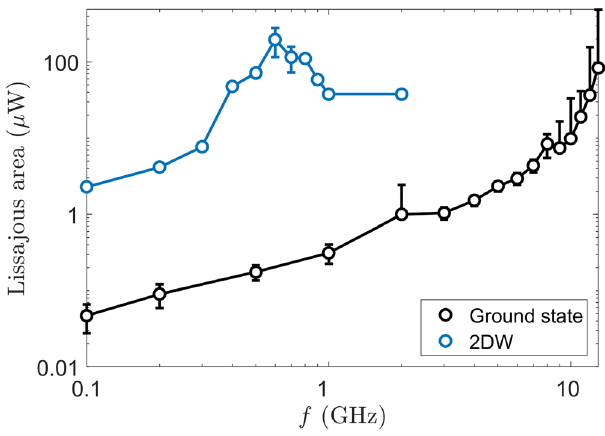
Fig. 6 Size of the memristive effects for domain walls (DW). Area spanned by the curves of the ground state and the 2DW state in Figs. 3 and 5. The area provide an estimate of how large is the change of the resistivity as a function of the frequency of the voltage input per unit of ampere, as in Eq. (5b). The peak in Lissajous area for the 2DW state is at f = 600 MHz. The error bars denote standard deviation of the area based on numerical fl uctuations and transient effects in the Lissajous'